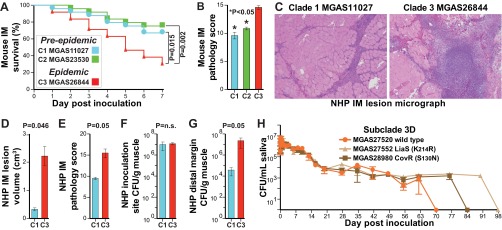
Virulence assays. (A) Kaplan-Meier survival curve for mice (n = 25/strain) inoculated intramuscularly in the right hind limb with 2.5 × 108 CFU. The genetically representative epidemic strain (MGAS26844) was significantly more lethal than the preepidemic strains throughout the period of observation. The index of the strains compared in panel A applies to panels A to G. (B) Histopathology scores for muscle tissue sections as determined by pathologists blind to the infecting strain. Data represent means (n = 5 assessments/strain) ± standard errors of the means (SEM). (C) Cynomolgus macaques were inoculated intramuscularly in the anterior thigh with 1.0 × 109 CFU/kg of body mass. Shown at the same magnification are micrographs of muscle tissue sections from the site of inoculation. (D and E) Epidemic strain MGAS26844 caused significantly larger lesions (D) with greater tissue destruction (E) than preepidemic strain MGAS11027. (F and G) Although the bacterial burdens were similar at the site of inoculation (F), they were significantly greater for the epidemic strain than for the preepidemic strain at the distal margin (G) showing greater dissemination. P values for panels B, D, E, F, and G were determined with the Mann-Whitney test. (H) Viability of naturally occurring variant strains MGAS28980 CovR (S130N) and MGAS27552 LiaS (K214R) in human saliva persisted for 2 and 4 weeks longer, respectively, than that of wild-type strain MGAS27520. No growth, <10 CFU/ml for a 1:10 dilution. IM, intramuscularly; NHP, nonhuman primate.